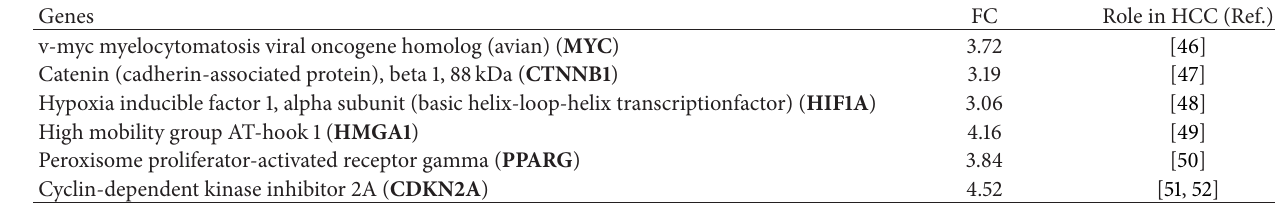
Table 4: Gene list known to be deregulated in HCC selected from our microarray data for cross validation as positive control (references are based on PUBMED